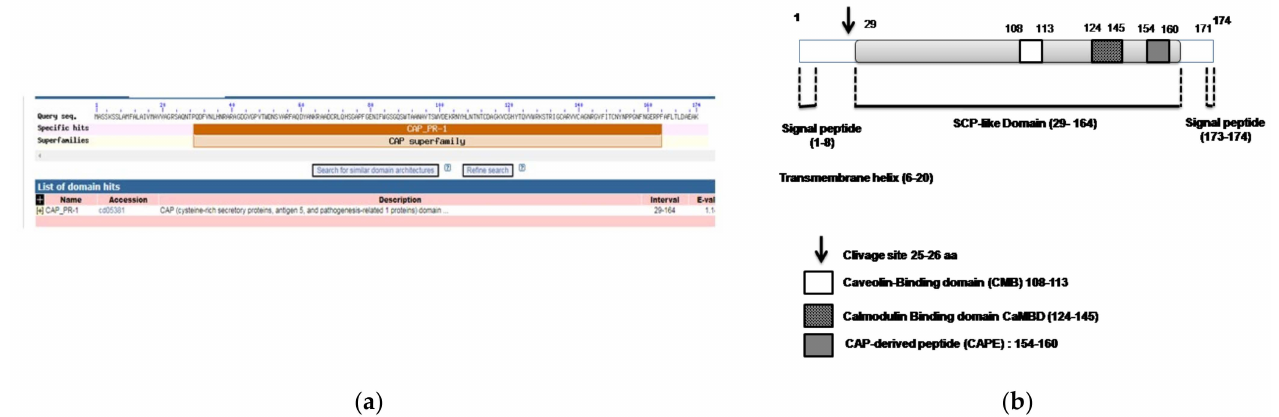
Figure 1. Bioinformatic analysis of AvPR-1 structure. ( a ) Analysis of AvPR-1 proteins using the NCBI server showed that AvPR-1 belongs to the CAP superfamily. ( b ) Conserved domains of the AvPR-1 protein. The predicted AvPR-1 protein contained a conserved motif at residues 29–164 aa that belonged to the CAP-superfamily. Two peptide signals were also identified in the N-(1–25) and C-(164–174) terminal parts with the presence of a transmembrane domain. AvPR-1 also contains a cleavage site at position